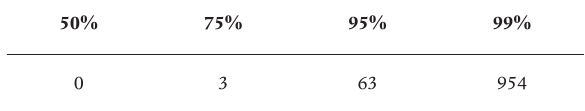
Table 5. Percentiles of the Landscan distribution of population for all of Kyrgyzstan. The distribution has an extended dynamic range, exceeding 42dB, with 95% of the grid population values below 63, and 99% of the grid cells with less than 1000 inhabitants.